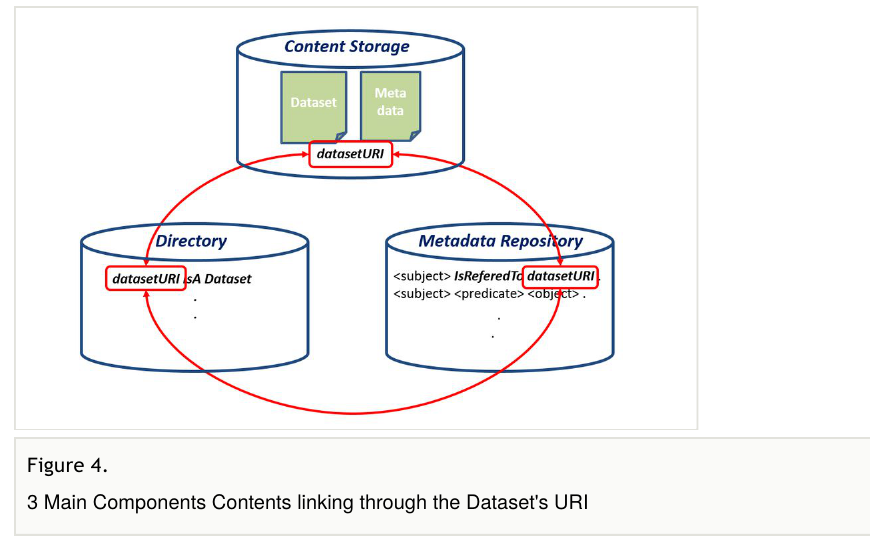
3 Main Components Contents linking through the Dataset's